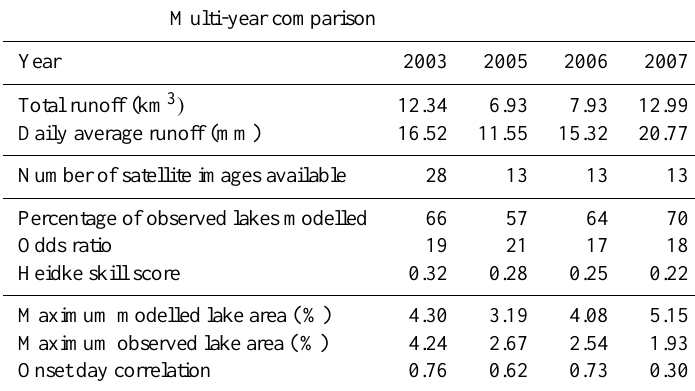
Table 2. Statistical description of the forecast skill in predicting lake locations in our study area between 1000 and 1600m elevation in 2003, 2005, 2006 and 2007. Also given are the maximum observed and modelled lake areas as a percentage of total area between 1100 and 1700m elevation, MAR-simulated runoff and the number of satellite images available for comparison with the model in each of those years. Daily mean runoff relates to the period of days 130 to 250, which we observe to be the period during which supraglacial lakes are seen in this sector of the